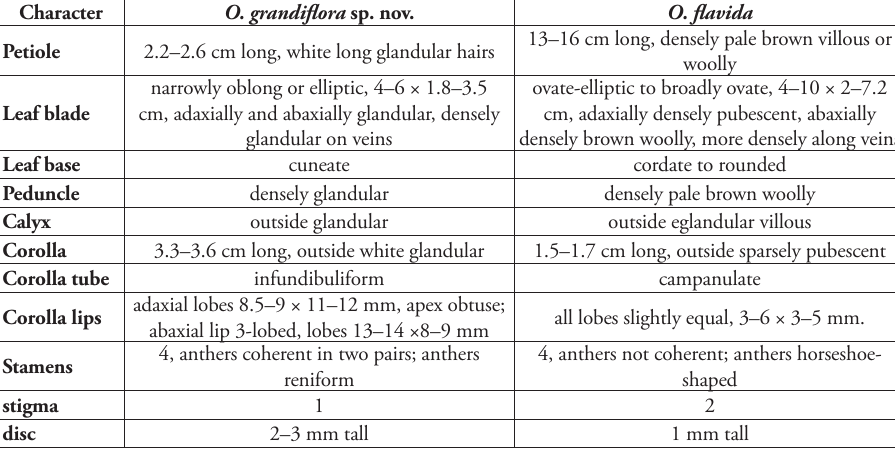
Table 1. Morphological comparison between Oreocharis grandiflora sp. nov. and O. flavida